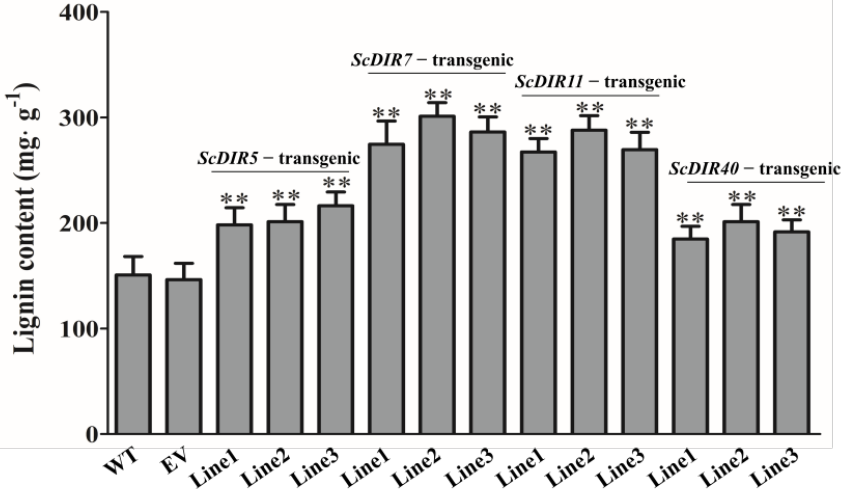
Figure 6. Lignin contents of ScDIR transgenic lines. Lignin content of tobacco leaves at the five − leaf stage was determined using a lignin assay kit. Error bars denote the standard deviation calculated from three independent experiments. Significant differences were determined by t − test. ** p < 0.01. PEG was used to simulate drought stress in transgenic tobacco [16]. After 15 days of drought treatment, the wild − type, empty vector (EV) − transgenic, ScDIR5 − transgenic, and ScDIR40 − transgenic lines gradually wilted, whereas the ScDIR7 − transgenic and ScDIR11 − transgenic lines grew and developed normally (Figure 7a). These results demon- strate that the overexpression of ScDIR can help tobacco survive for a longer period when exposed to drought